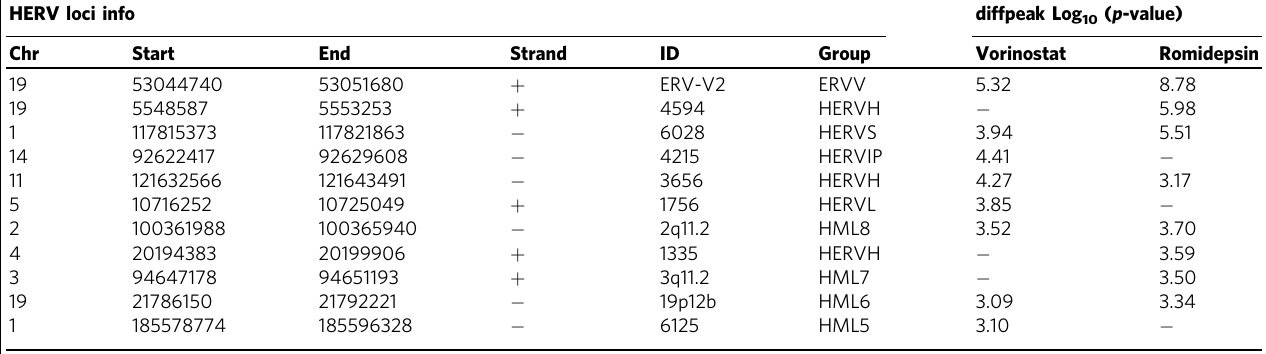
Differential peak (diffpeak) p -values are depicted as the mean of two independent CHIP-seq